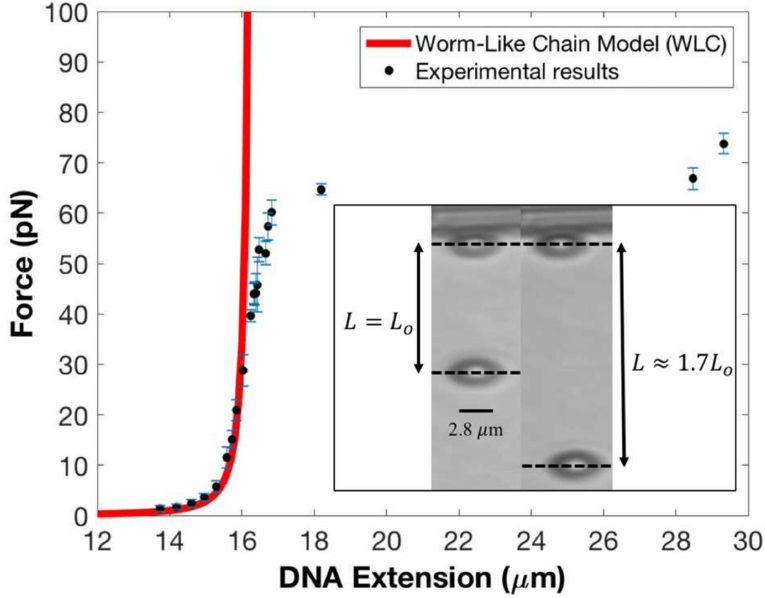
Figure 2. Experimental results of force vs DNA extension experiments on λ -DNA using the horizontal magnetic tweezers. Our data are represented by the solid black circles; corresponding standard errors in the forces are shown by blue lines. The solid red line represents the worm-like chain model for a single DNA molecule’s response to force, which agrees well with our data in the 1.0 pN to 40 pN force range. This corresponds to DNA extension from 13.7 µ m to 16.2 µ m. Between 40 pN to 60 pN our data begins to deviate to the right from the worm-like chain model. This is the region where the DNA is at is full contour length (around 25 pN) and then begins to stretch. At force range of 52.8 pN up to 60.1 pN with corresponding DNA extension of 16.5 µ m up to 16.8 µ m, our data further shifted to the right from the worm-like chain model. At force range of 64.7 pN up to 73.7 pN with corresponding DNA extension of 18.2 µ m up to 29.3 µ m, the DNA tether undergoes the overstretching transition with its zero-force contour length L o increasing by 70% of L o . The inset shows two snapshots from our DNA extension experiments. From left to right, the first snapshot shows a single DNA with contour length of 16.4 µ m with the tethered bead 550 µ m from the magnet and corresponding to a force of 44.2 pN. The second snapshot shows a single DNA molecule in the overstretching transition with an extension of 28.5 µ m, ~1.7 L o , at 430 µ m from the magnet for a force of ~66.8